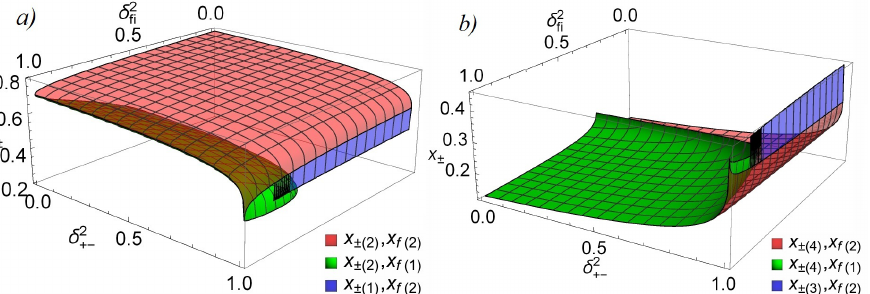
(cid:16) (cid:17) δ 2 , δ 2 + − (see Expressions (23) and (24)) fi